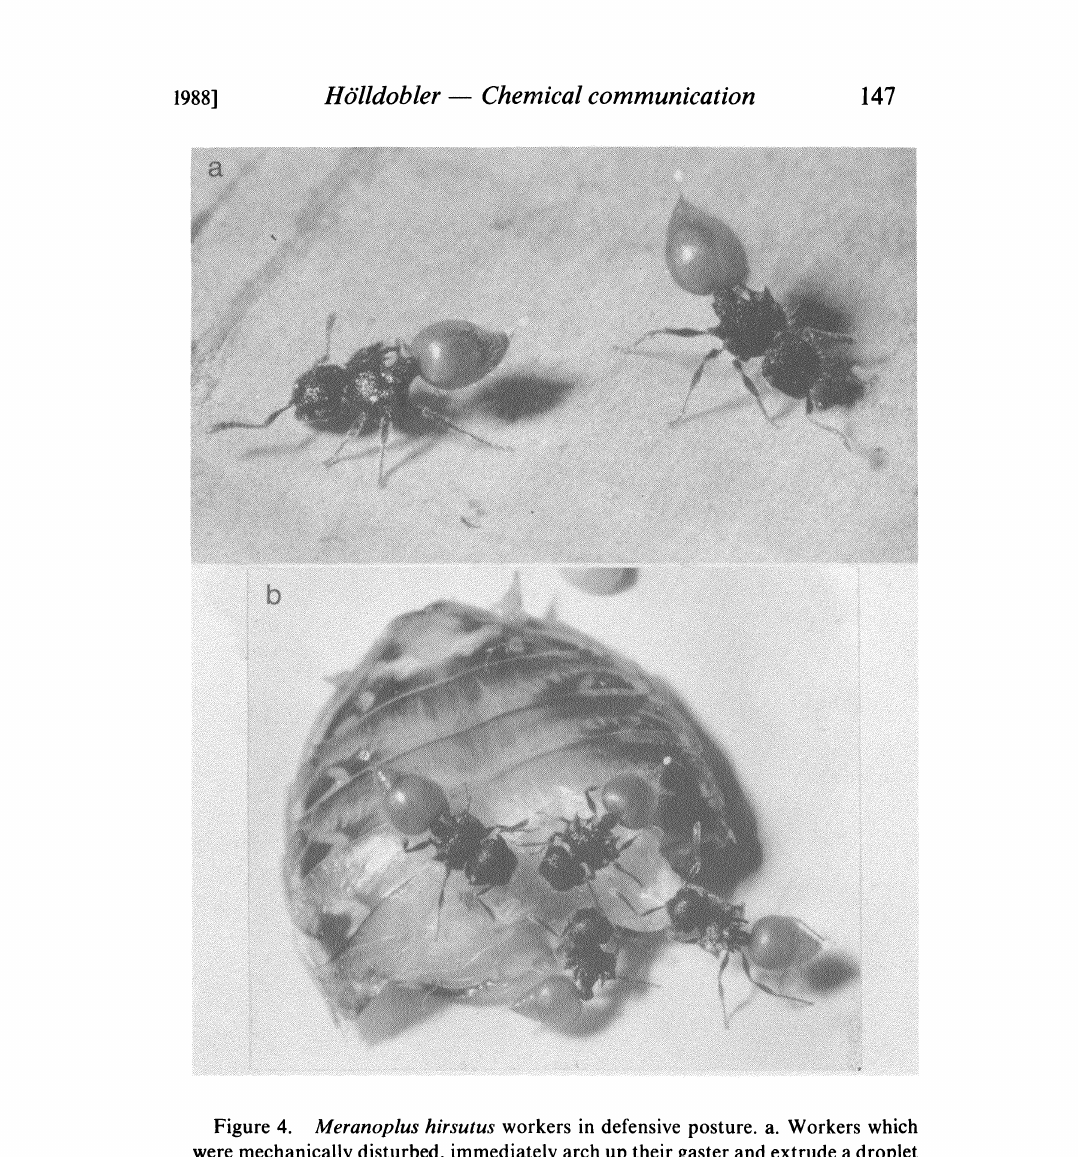
Figure 4. Meranoplus hirsutus workers in defensive posture, a. Workers which were mechanically disturbed, immediately arch up their gaster and extrude a droplet of Dufour’s gland secretions on the exposed sting, b. The same behavior can be observed in workers guarding a piece of